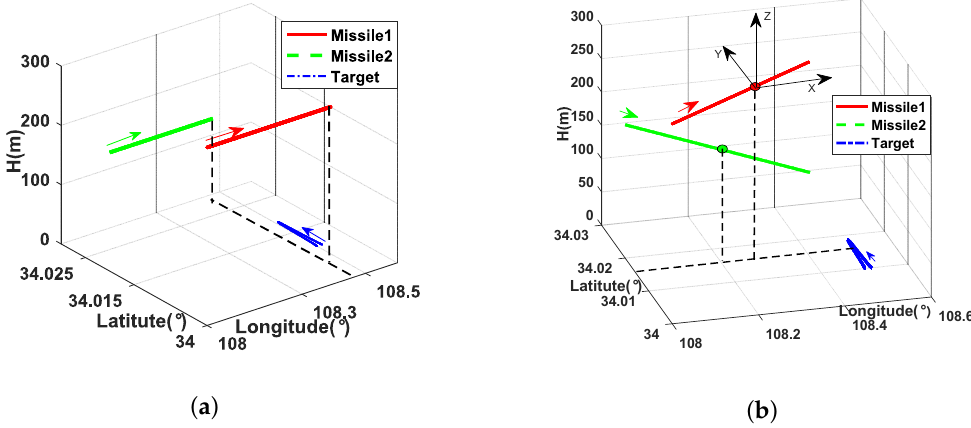
Figure 5. ( a ) Trajectories of missiles and target under case 1; ( b )Trajectories of missiles and target under case